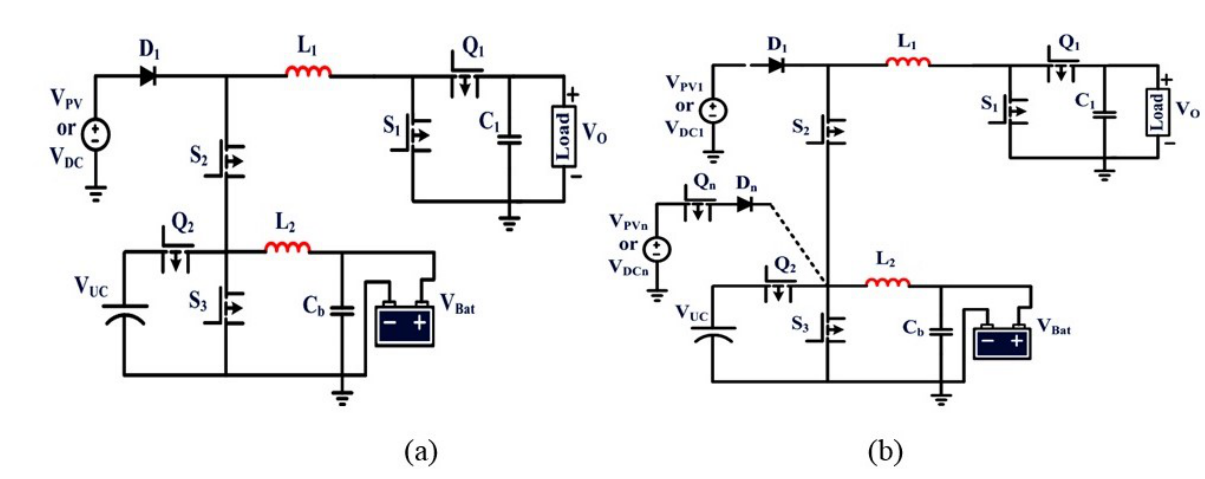
Fig. 2. Proposed converter (a) Four-port bidirectional buck-boost converter (FPB 3 C), (b) Multi-port bidirectional buck-boost converter (MPB 3